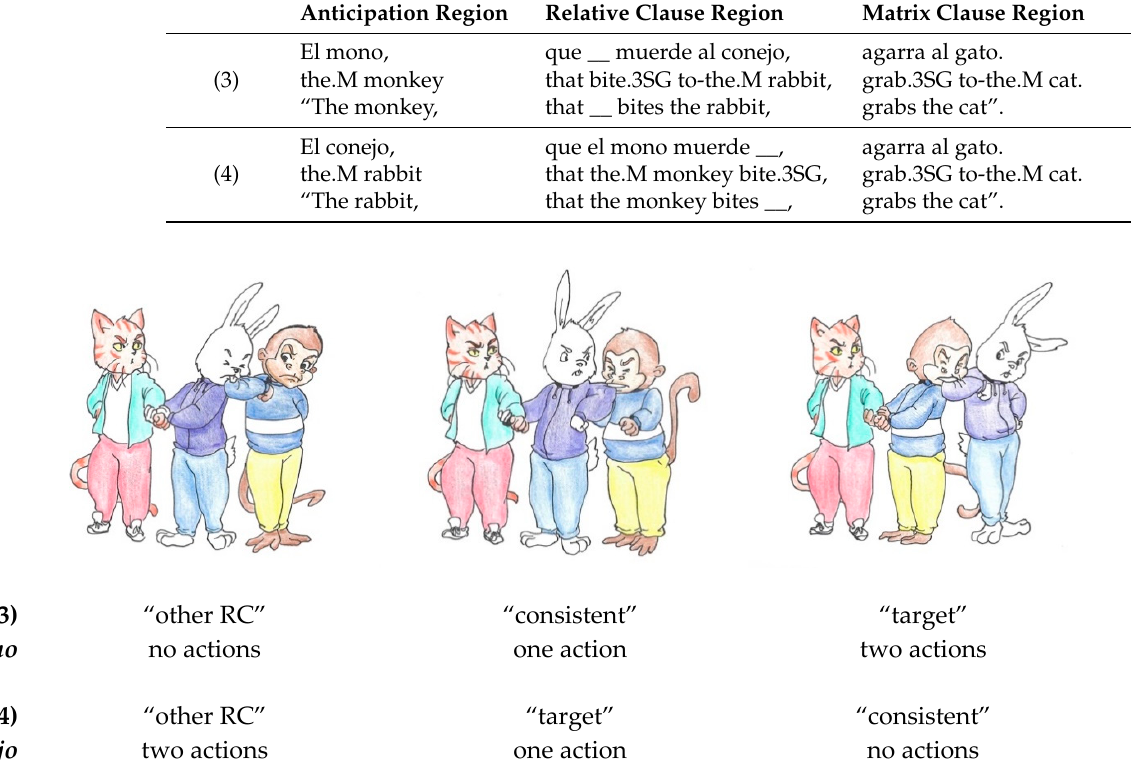
Figure 2. Example materials for an experimental visual context corresponding to (3) and (4).